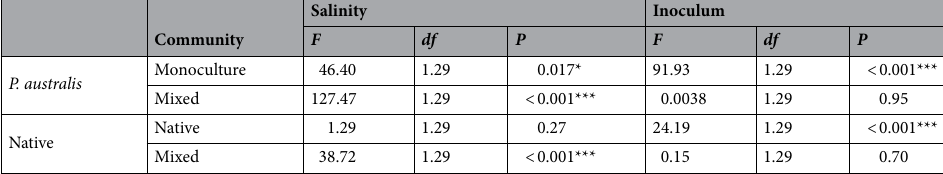
Table 1. Two-way ANOVA results testing the effects of salinity (direct effects) and microbial inoculum (indirect effects) on P. australis biomass in monoculture and mixed communities and on pooled native